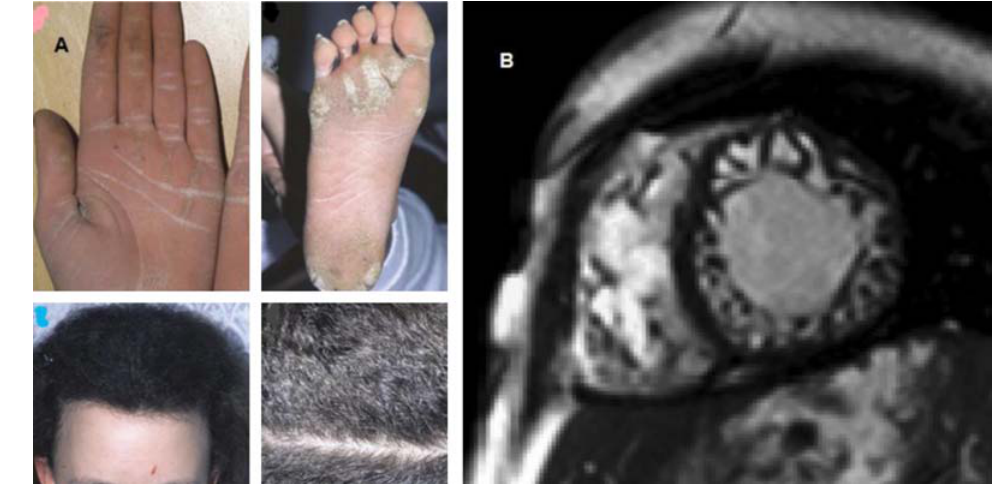
Figure 10. A: Cutaneous features of Carvajal syndrome, including wooly hair, palmoplantar keratosis [39]. B: Cine true fast imaging with steady-state precession image in the short-axis orientation shows dilatation and a trabecular disarray of both ventricles with the appearance of a noncompaction syndrome. This patient was found to have Carvajal syndrome postmortem. He was living in Germany at the time of study however, his family origins were from the city Giresun of Tirebolu near Azerbaijan [40].